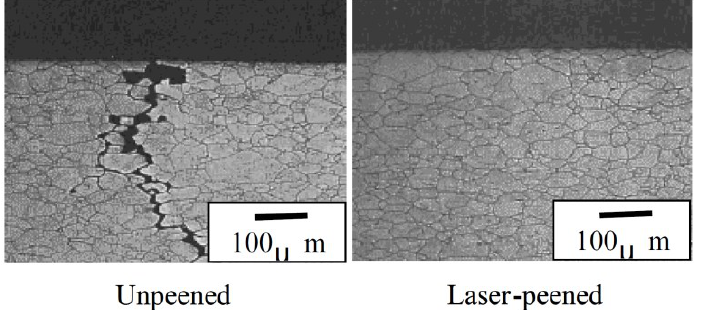
Figure 21. Microstructure of the cross section of the SCC tested 304SS samples